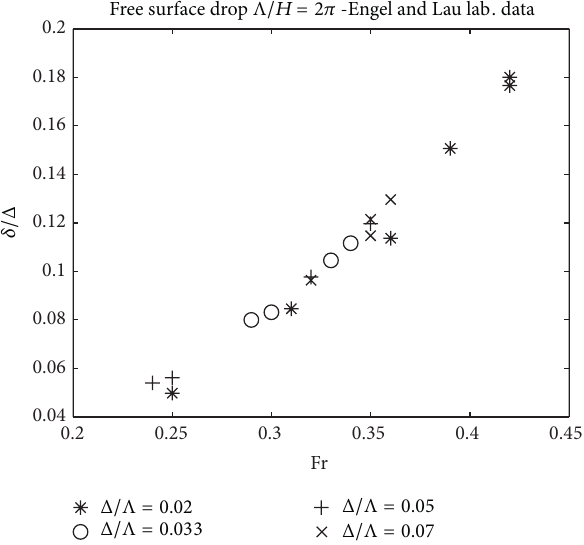
Figure 8: Behaviour of the dimensionless asymptotic dispersion coefficient as a function of the skin friction factor for different dune